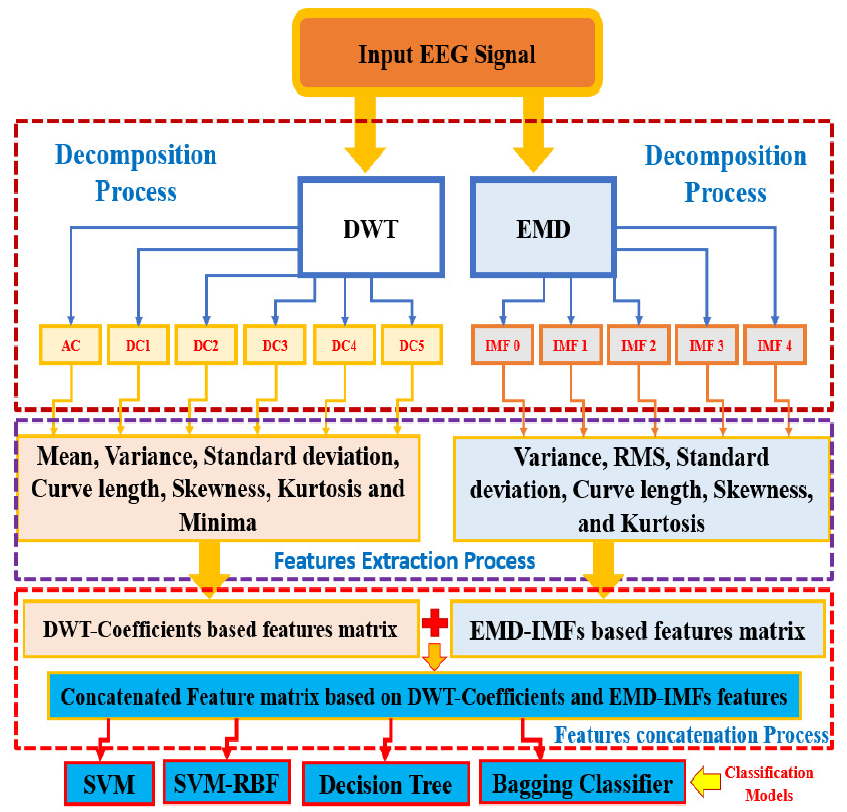
Figure 3. Illustrative diagram of the proposed approach.